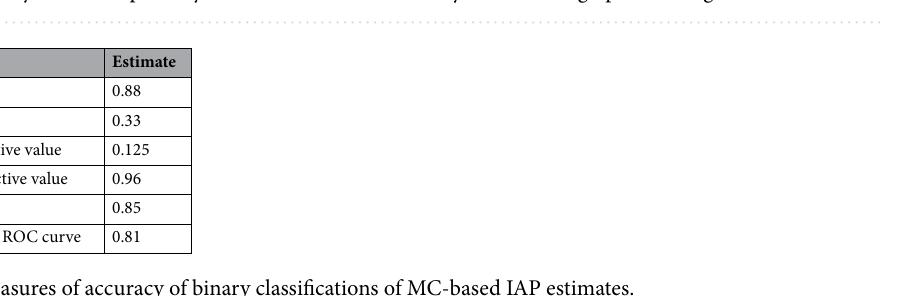
Table 6. Measures of accuracy of binary classifications of MC-based IAP